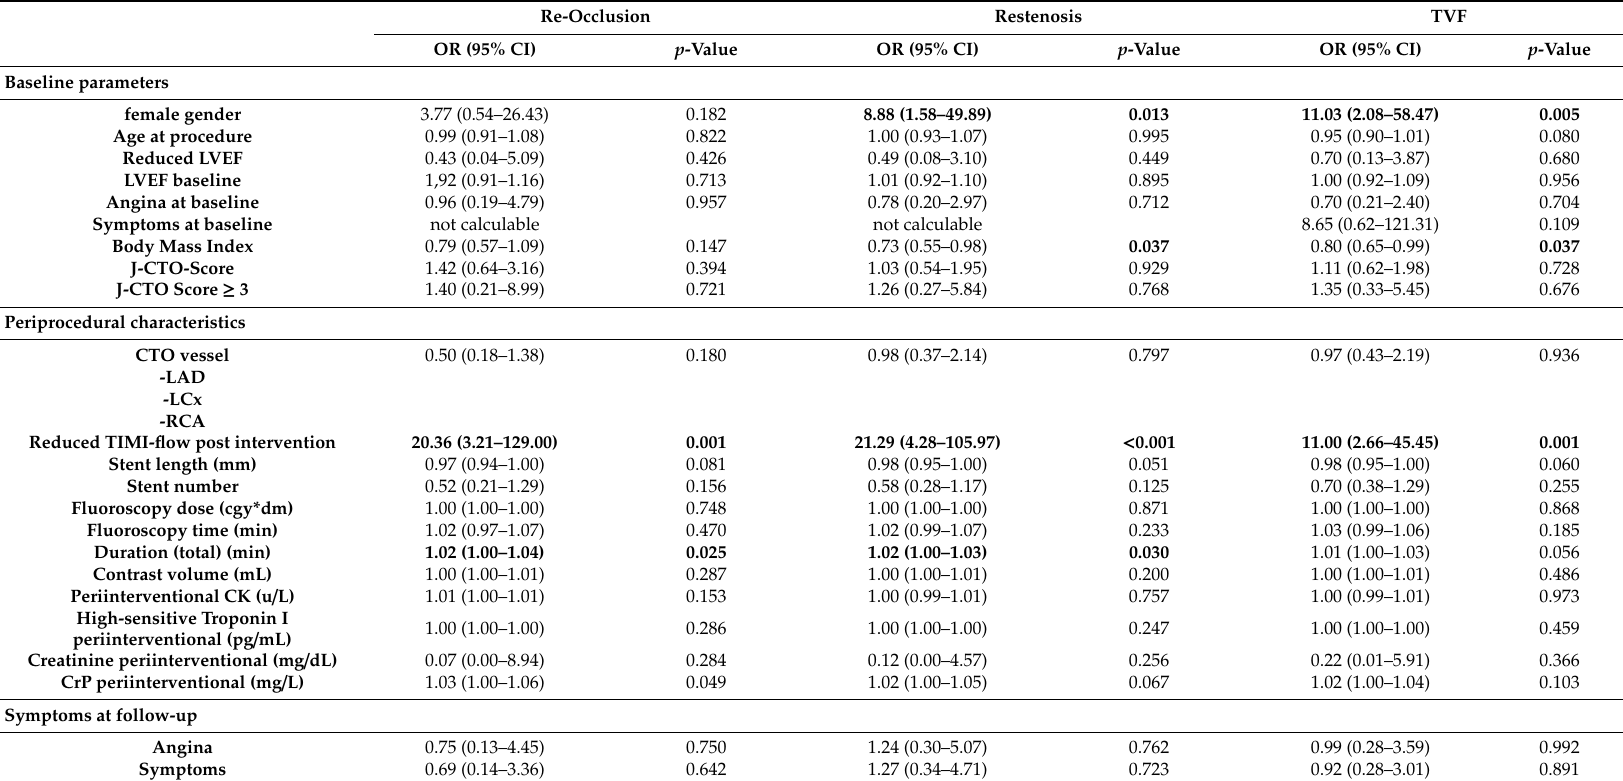
Table 3. Multivariate regression analysis (odds ratios) for re-occlusion, restenosis, and